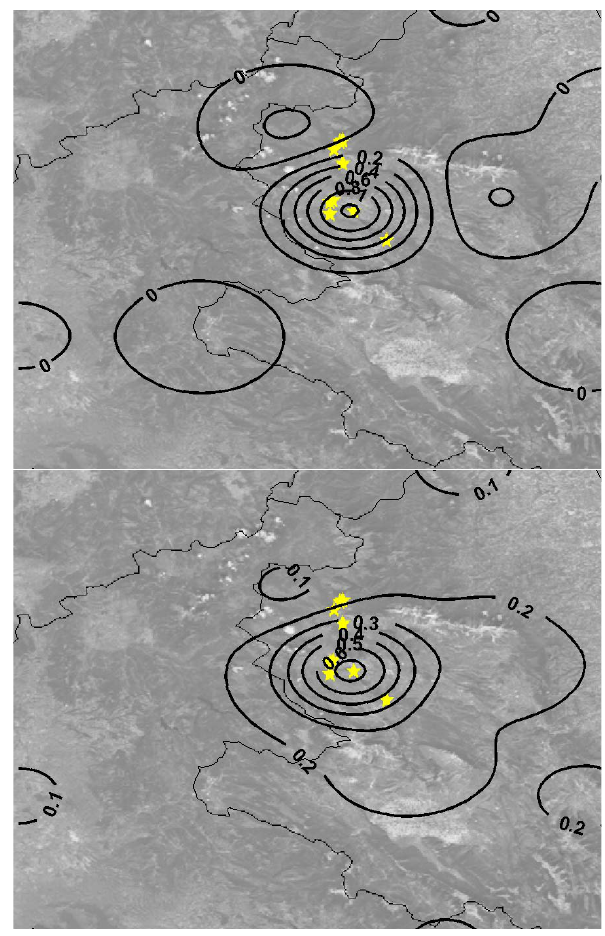
Fig. 10. Contour plot of the ionospheric delay variation–JD88 (top) and JD94 (bottom). Yellow stars show the locations of the earthquakes epicentres ( M ≥ 4.0) from 6 April to 13 April